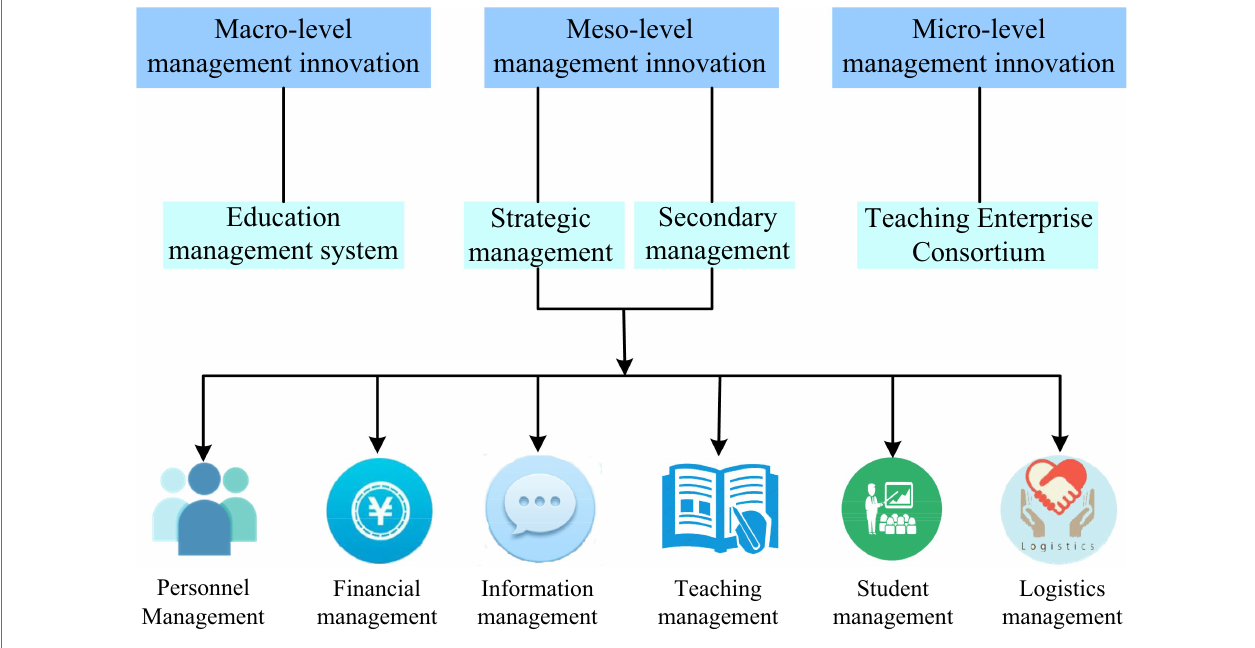
FIGURE 1 | The basic framework of university psychology management